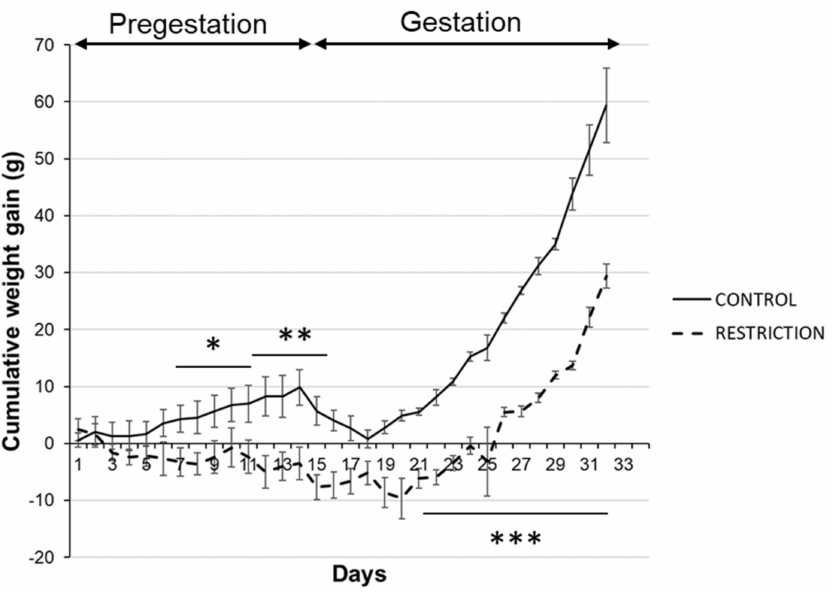
Figure 1. Maternal weight gain during pregestation and gestation periods. Cumulative weight gain (g) of control (continuous line) and restricted dams (dashed line) during pregestation and gestation. Values are expressed as means ± SEM. * p < 0.05, ** p < 0.01, *** p < 0.001. During the overall gestational period, calorie-restricted dams also gained body weight, but it was delayed when compared with control rats (*** p < 0.001; Figure